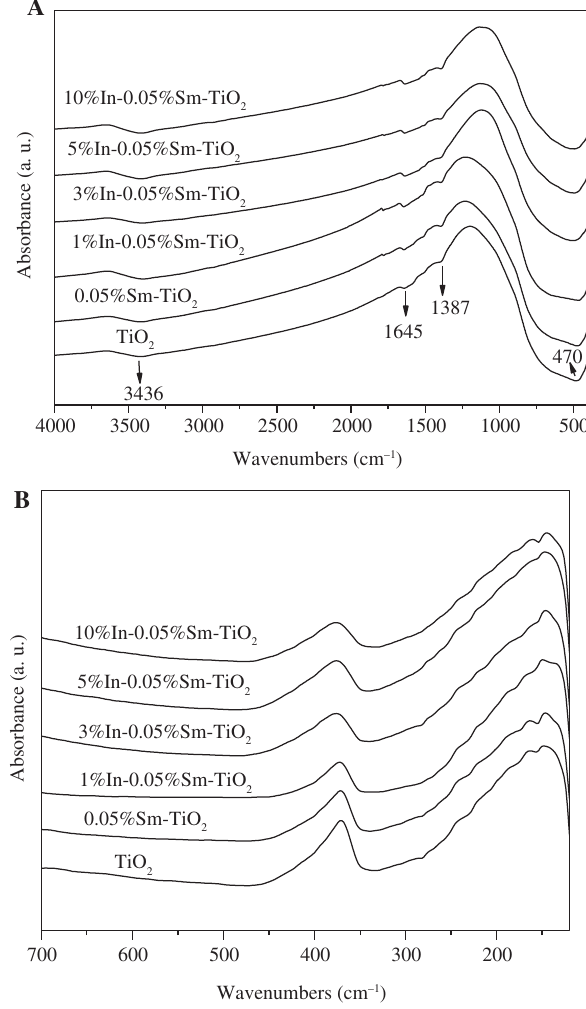
Figure 3: (A) FT-IR and (B) FT/far IR spectra of x In-0.05%Sm-TiO samples and pure TiO